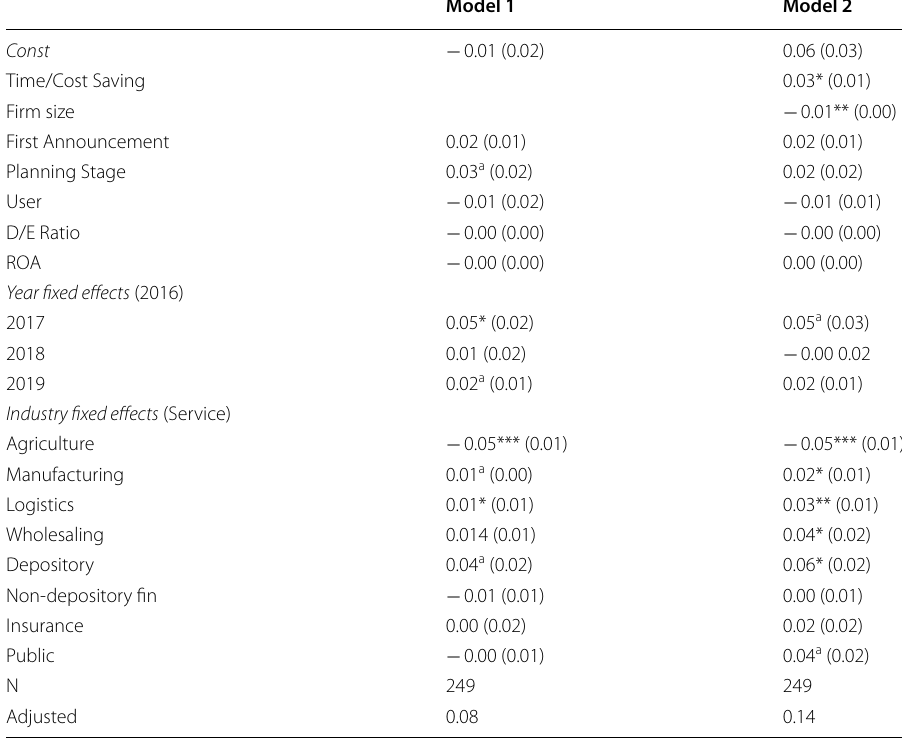
Table 8 Regression model for global sample